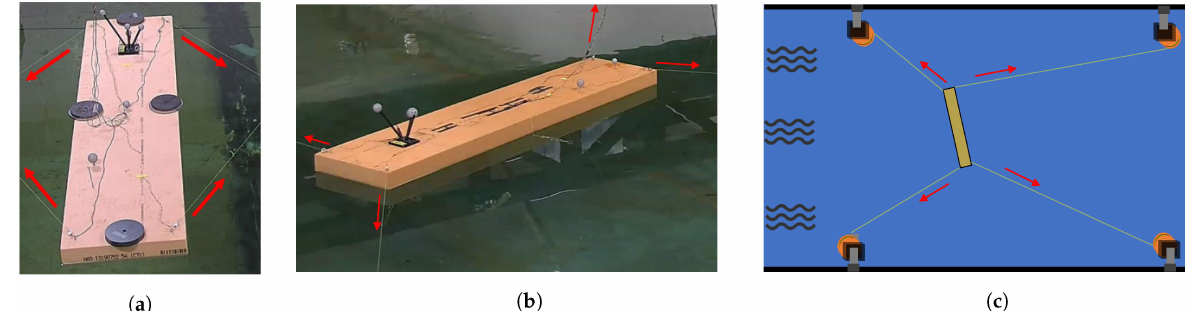
Figure 3. ReaTHM testing of a moored barge using a planar CDPR. Red arrows mark the direction of the actuated force, passed axially through each cable. ( a , b ) Image from laboratory setup of the authors [8]. ( a ) Crossed configuration. ( b ) Uncrossed configuration. ( c ) Schematic